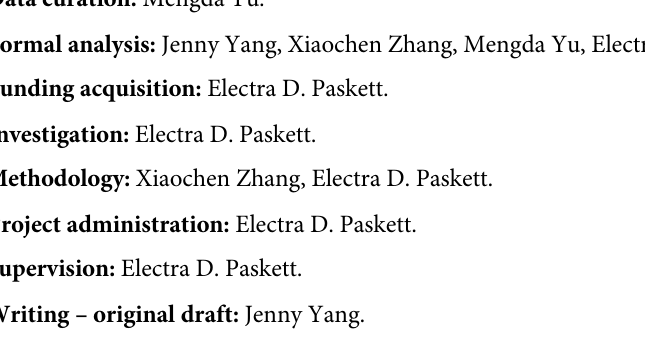
S1 Table. Demographic characteristics between participants included and excluded from the